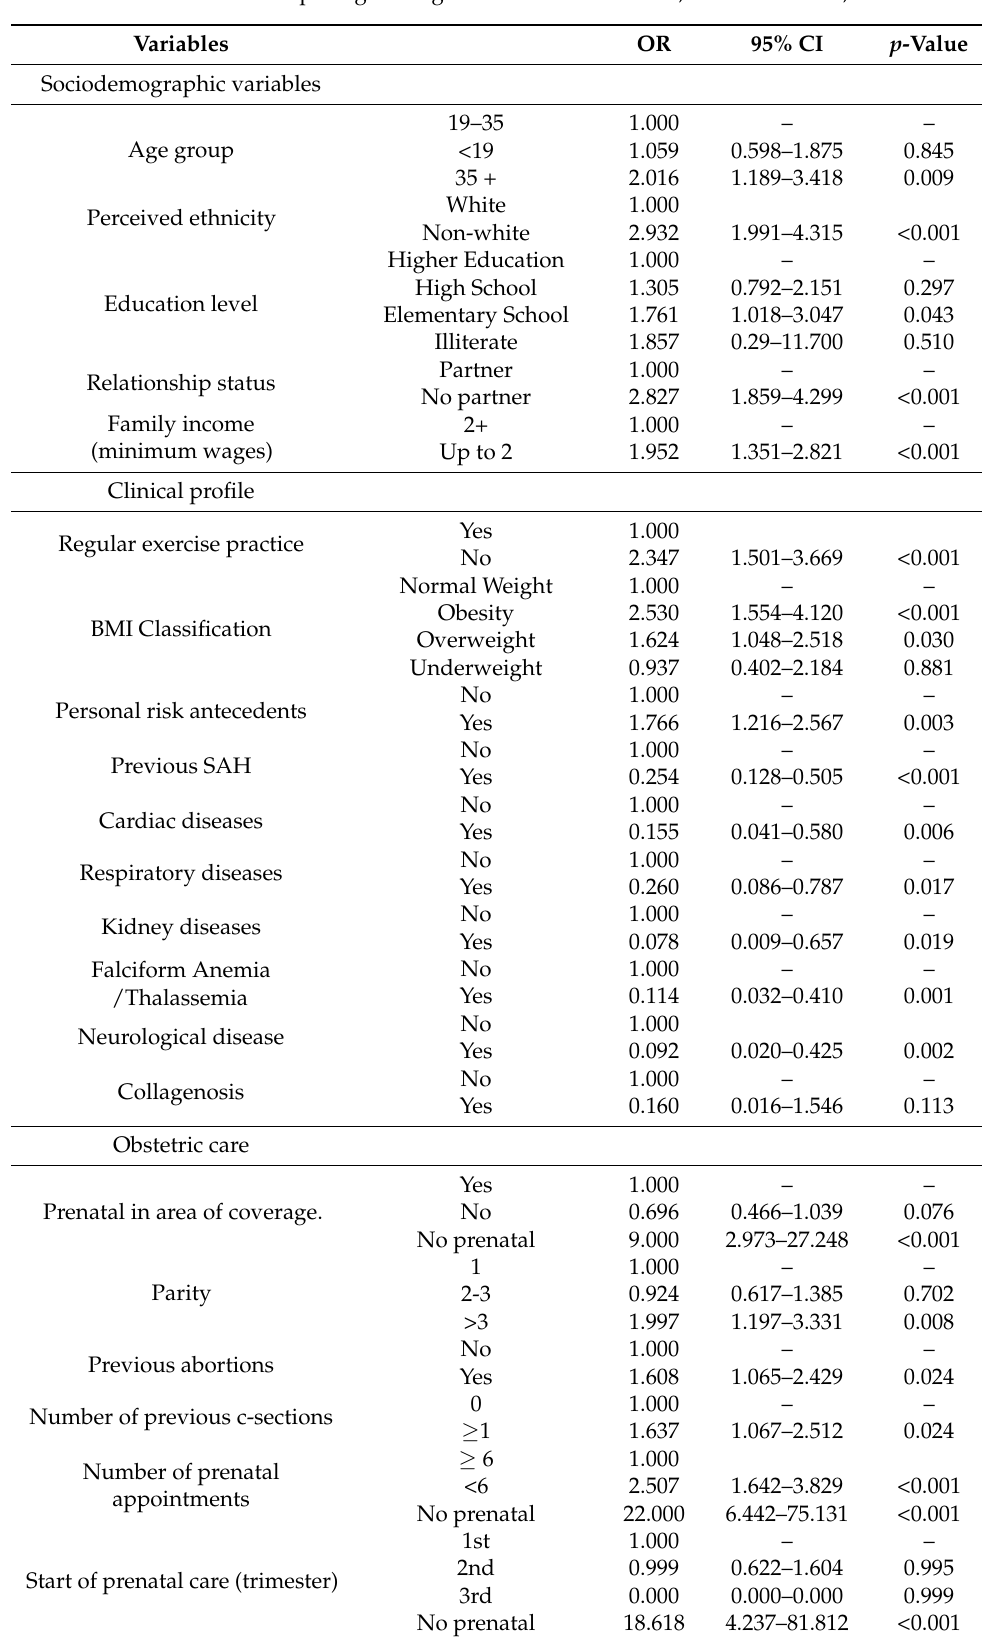
Table 3. Results from the simple logistic regression models. Bras í lia, Federal District,